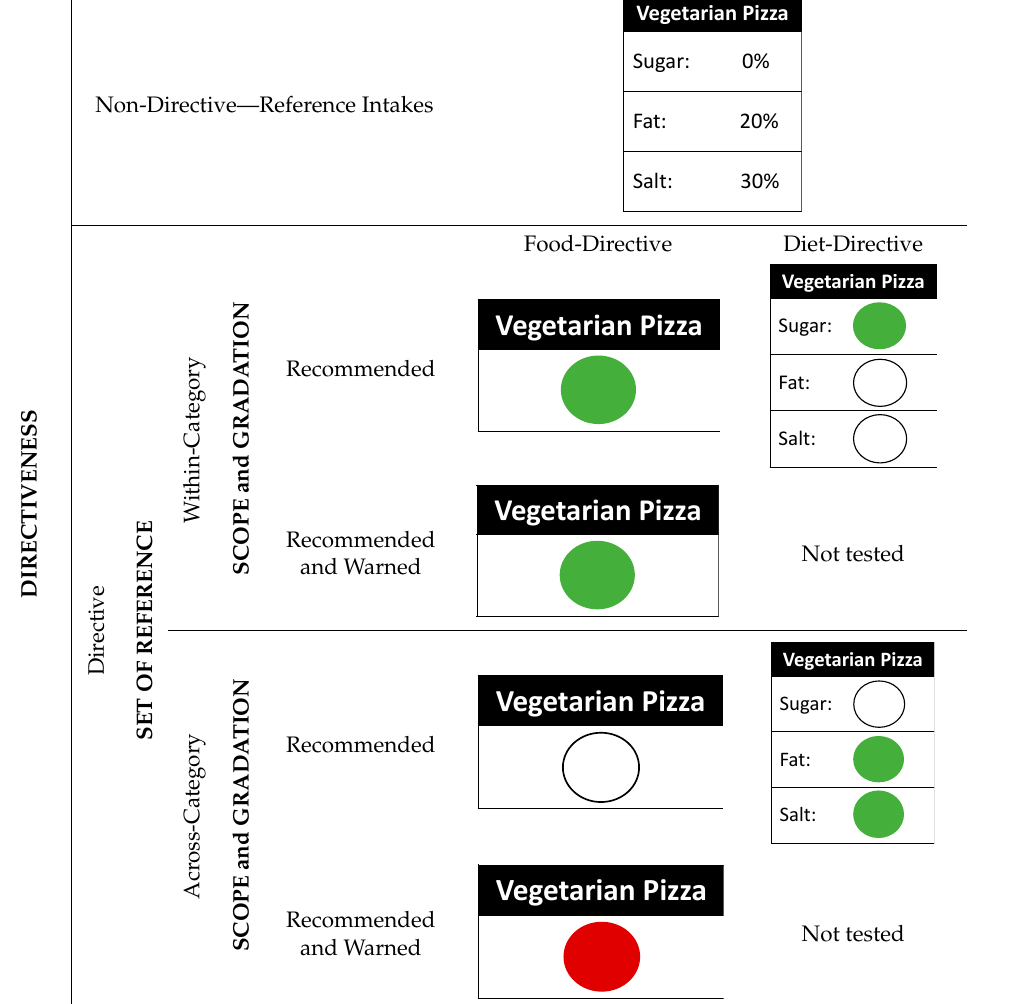
Table A1. The seven prototype FoPLs tested in our study illustrated with the example of the vegetarian pizza.